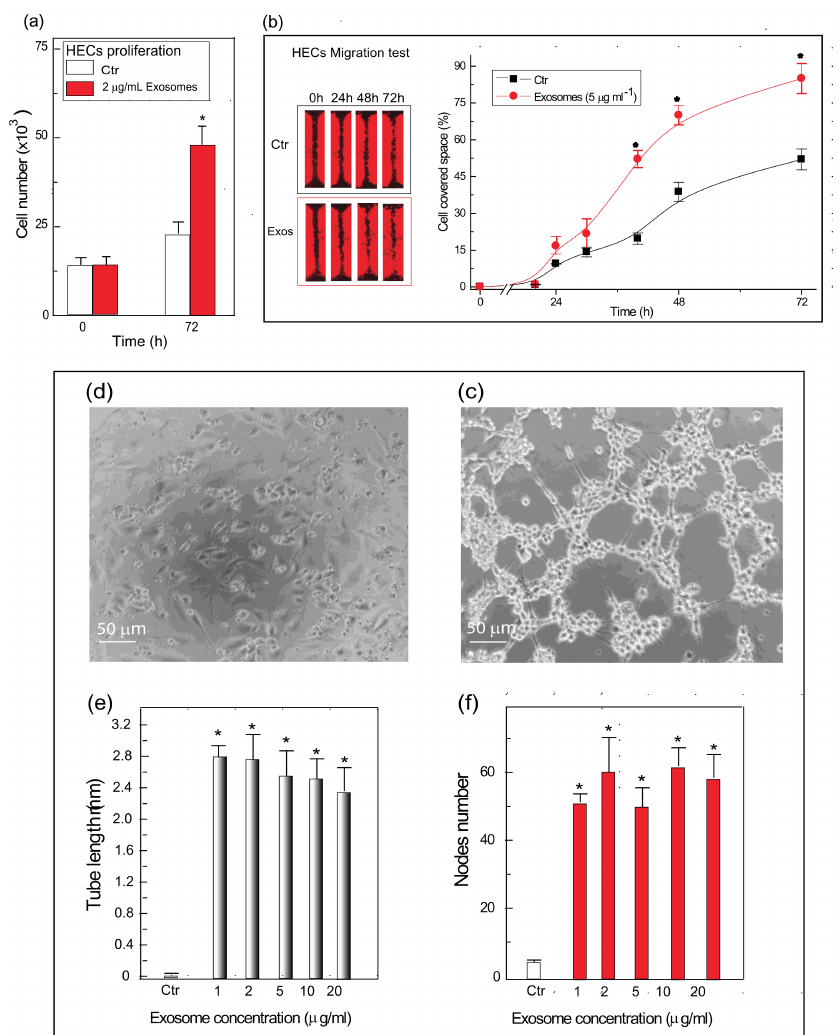
Figure 4. Exosomes released from AHSMCs grown on C/HE-3D-SFnws induce HECs’ proliferation, migration, and tubes and nodes formation in vitro. ( a ) Stimulation of HECs’ growth: exosomes (2 µ g mL − 1 ) released from C/HD-3D-SFnws-adhering AHSMCs when added to HECs cultured in Endothelial Cell Basal medium plus 10% v / v exosome-depleted FBS strongly increased the numbers of viable cells 72 h later, as revealed by CellTiter-Blue ® assay vs. the untreated cells (Ctr). *, p < 0.05 vs. Ctr. See Materials and Methods for technical details. ( b ) Stimulation of HECs’ migration: adding exosomes (5 µ g mL − 1 ) released from the C/HE-3D-SFnws-bound AHSMCs to HECs cultured in Endothelial Cell Growth Basal Medium fortified with 2.5% v / v exosome-depleted FBS significantly advanced their migration into the “wound area” between 24 h and 72 h as compared to untreated HECs (Ctr), as the gap’s space covered by the exosome-treated HECs was, by 72 h, about double ( p < 0.05) that occupied by the untreated cells (Ctr). For technical details consult the Section 2.11. ( c , d ) Tube and nodes formation: micrograph ( c ) showing plain attached HECs 5 h after seeding into a 96-well plate onto Extracellular Matrix (ECM) gel. In each of these wells 20 × 10 3 HECs were incubated at 37 ◦ C in Endothelial Cell Growth Basal Medium fortified with 2.5% v / v exosome depleted FBS. No AHSMC-released exosomes were added. Micrograph ( d ) shows HECs 5 h after seeding onto ECM gel while being simultaneously exposed to increasing concentrations of exosomes released from C/HD-3D-SFnws-adhering AHSMCs, starting from 1 µ g mL − 1 to 20 µ g mL − 1 ; all the other conditions as in ( c ). Endothelial tube formation was strongly induced by the AHSMCs exosomes. ( c , d ), Phase contrast microscopy. Original magnification, 100 × . ( e , f ) Bar graph showing the total length (in mm) of newly formed endothelial tubes (e) and the number of nodes ( f ) per